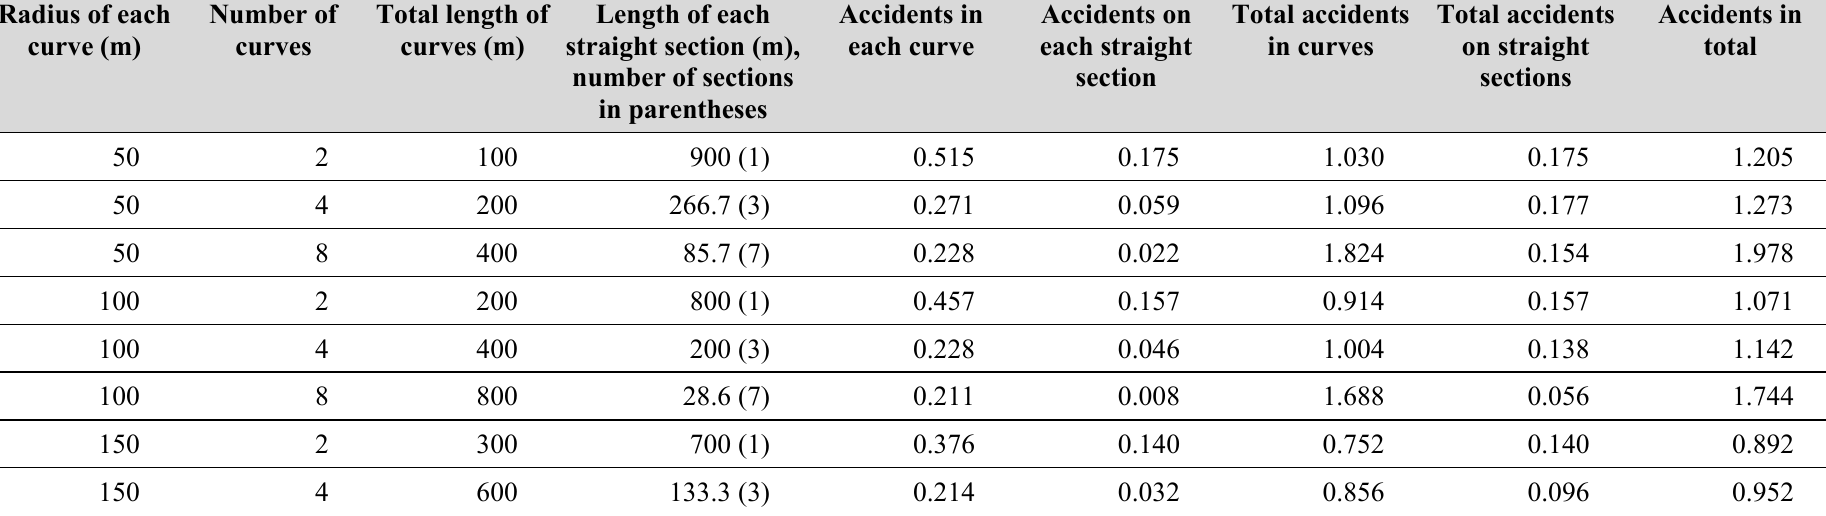
Accidents in Accidents on Total accidents Total accidents Accidents in each straight on straight each curve in curves section sections